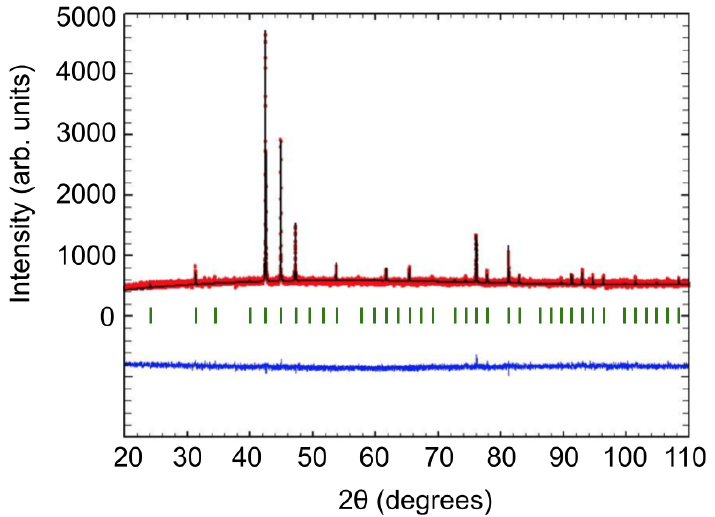
Figure 2. The Rietveld refinement for the powder X-ray diffraction of Co 8 Zn 8 Mn 4 . The black curve is the predicted spectra, the red line is the data, and the blue is the difference between the two. The green vertical lines indicate the locations of the expected peaks. The refinement demonstrates the sample is phase pure with space-group β -Mn and lattice constant 6.37161 ( 1 )